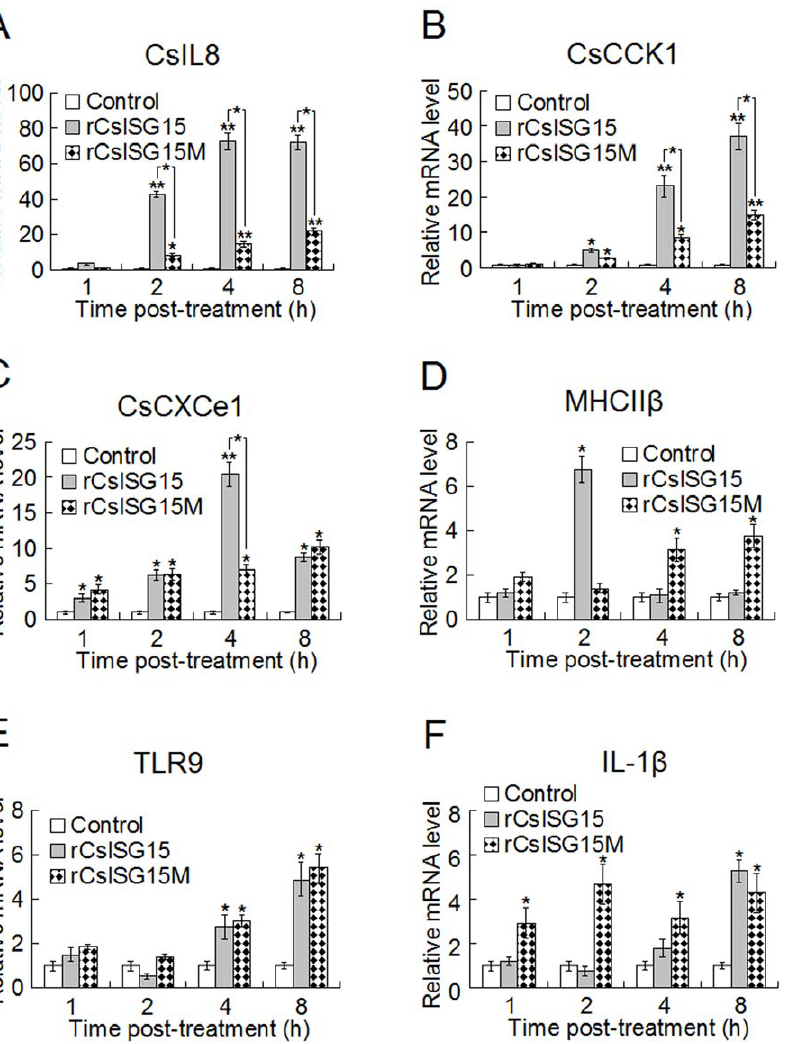
Figure 7. Effect of rCsISG15 and rCsISG15M on the expression of immune genes in lymphocytes. Tongue sole head kidney lymphocytes were treated with or without (control) rCsISG15 or rCsISG15M, and the expression of immune relevant genes was determined by quantitative real time RT-PCR at various time points. The assay was performed three times, and the results are shown as means 6 SE. * P , 0.05; ** P , 0.01.